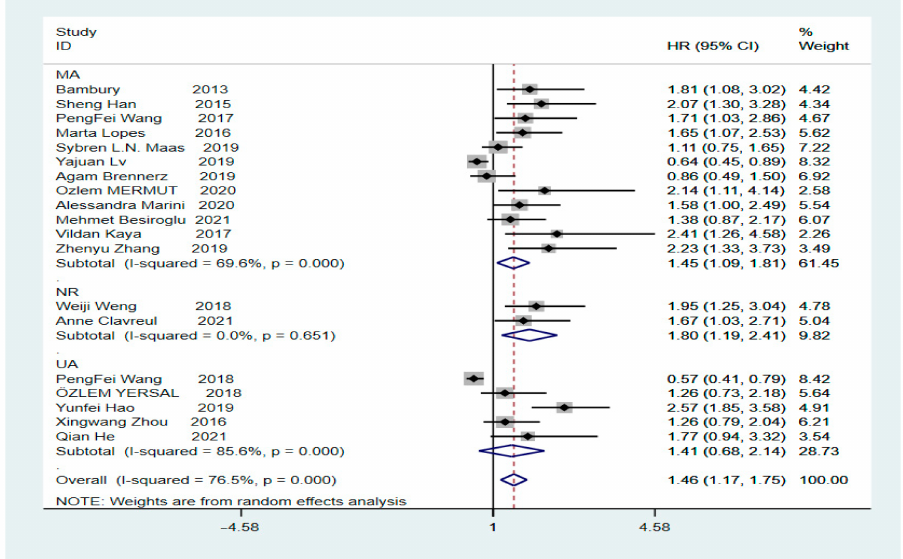
Figure 5. Analysis of subgroups with different sources of endings. Table 3. Meta-regression of baseline data . Coef.